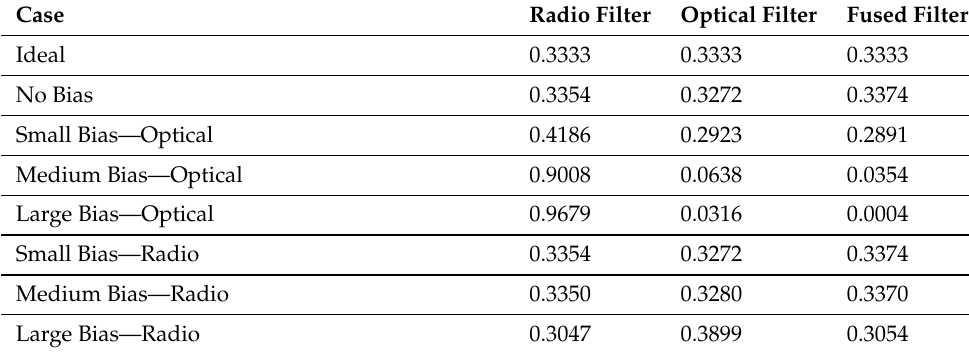
Table 3. Average Optimal Gating Network Weights for Biased Measurement